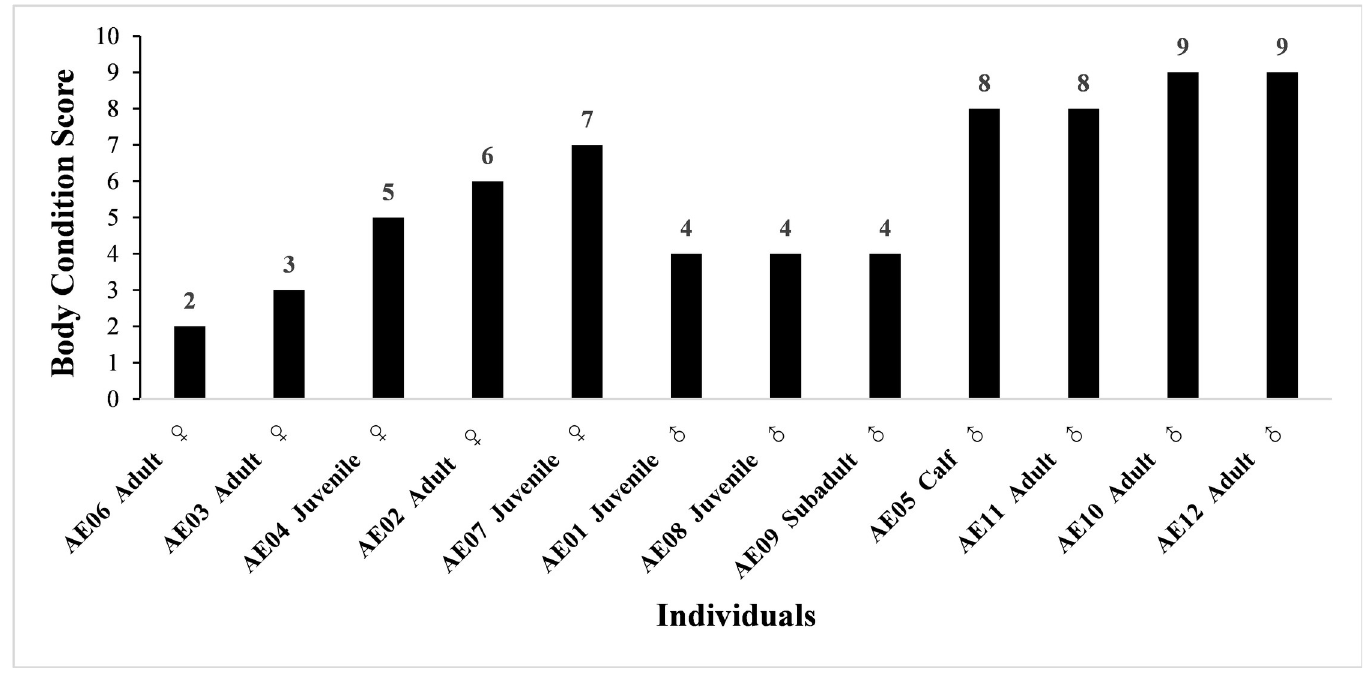
Fig 3. Body condition score of the 12 individuals identified in